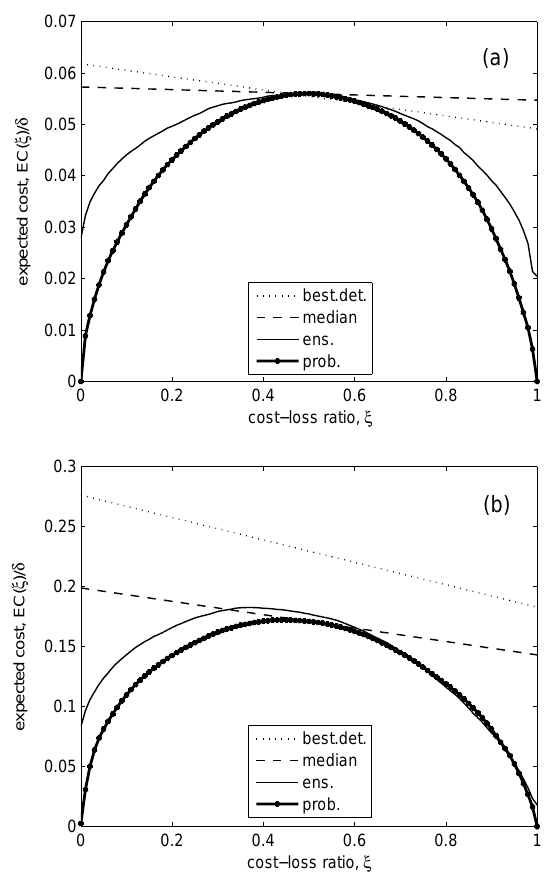
Fig. 4. Representation of the expected cost from Eq. (9) (re-scaled by the mean deviation δ ) as a function of the cost-loss ratio ξ , for a 1 step-ahead (a) and a 6-steps ahead (b) hourly discharge predic- tion. The four lines in each graph refer to four different forecasting methods, described at the beginning of Sect.